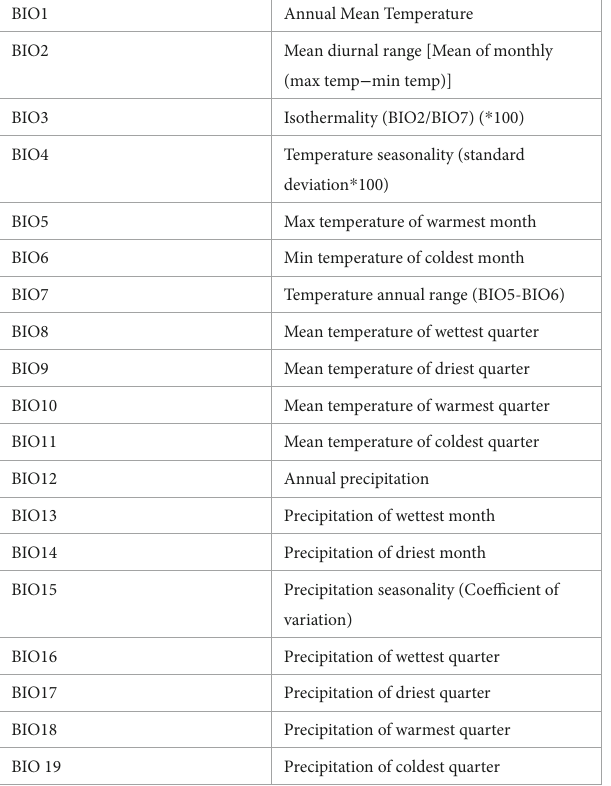
TABLE 4 Environmental variables used to predict Faidherbia albida distribution in Cabo Verde; non-highlighted variables were removed after applying Variance Inflation Factor (VIF) analysis to reduce collinearity.